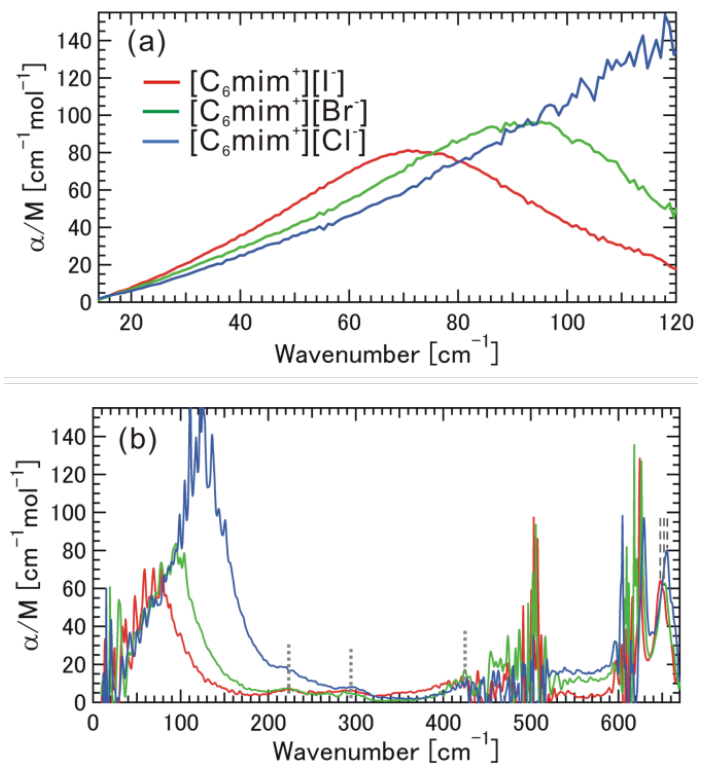
Figure 5. Absorption coefficients (α/M) normalized by molar concentration obtained from ( a ) THz-TDS and ( b ) FIR, for the ionic liquid [C 6 mim + ][I − ], [C 6 mim + ][Br − ], and [C 6 mim + ][Cl −